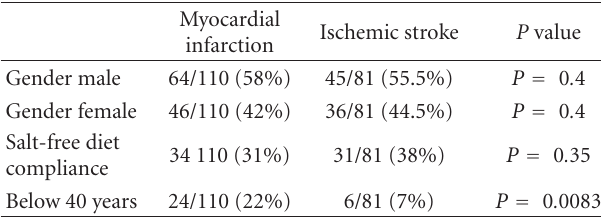
Table 1: Gender distribution, salt-free diet compliance, and age below 40 years in patients with myocardial infarction and ischemic